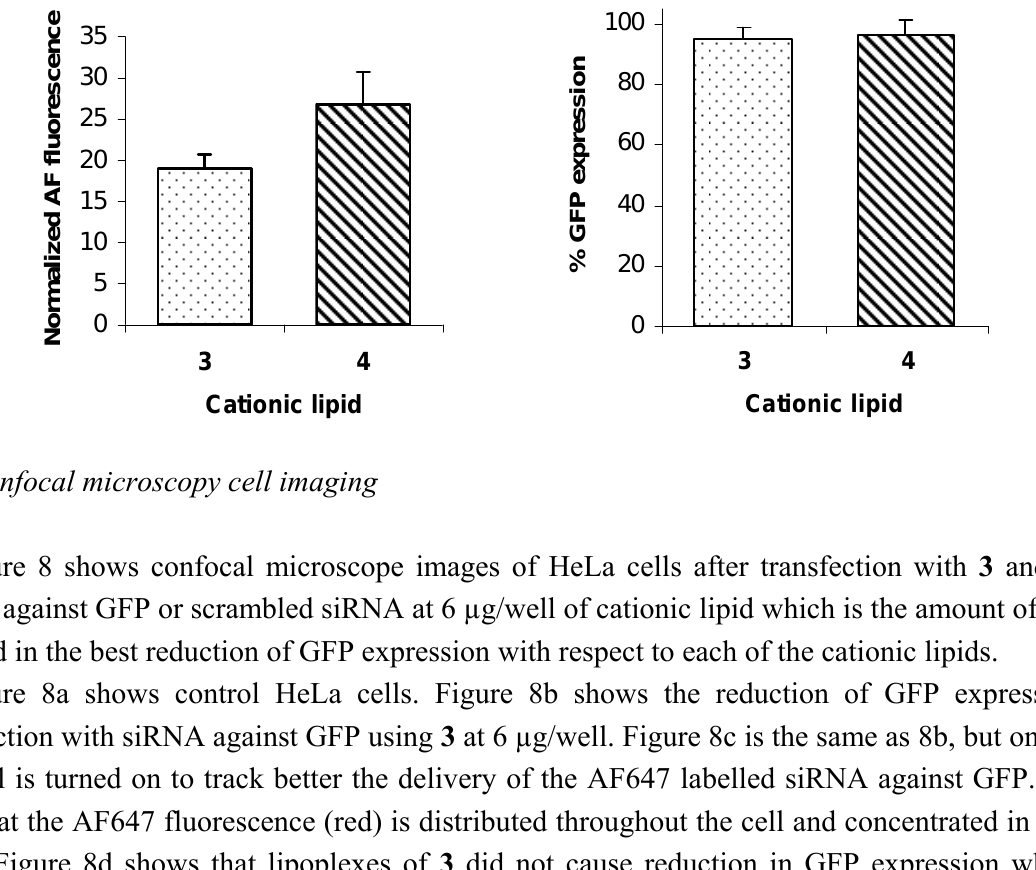
Figure 7. Scrambled AllStars siRNA (with an Alexa Fluor® 647 tag at the 3'-position) (15 nM, 15 pmol/well) was delivered with cationic lipids 3 and 4 (at 6  g/well). Delivery of tagged siRNA (left) is expressed as AF647 normalized geometric mean fluorescence ± SD (n = 6) measured at  = 660 nm. GFP percentage expression (right) (absence of silencing as a negative control) 48 h post transfection is measured at  = 530